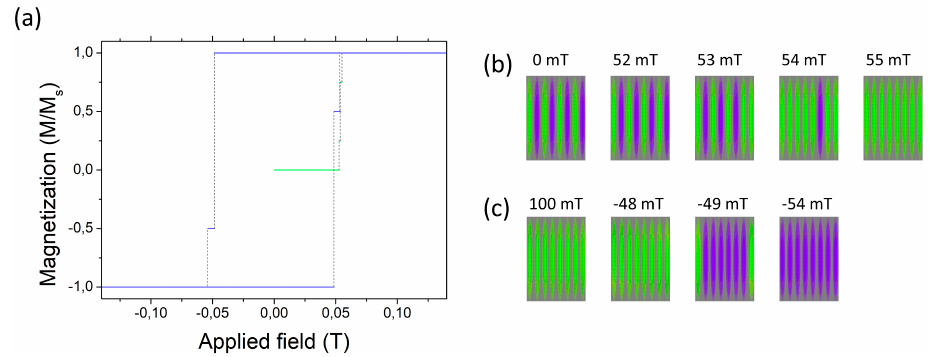
Figure 11. ( a ) Hysteresis loop for the system of eight ellipsoids. The configuration sequence when starting ( b ) from AF and ( c ) from FM configuration.